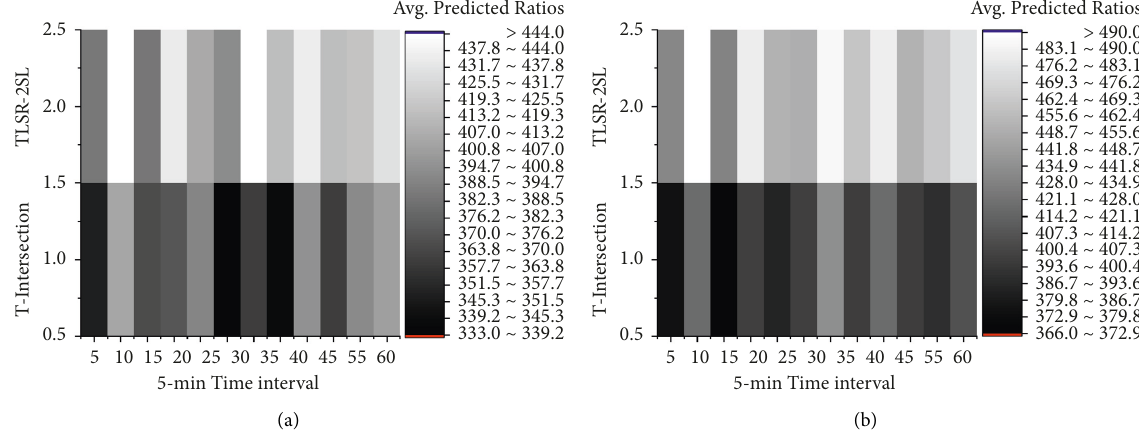
Figure 8: E-S flow comparative analysis between T-intersection and TLSR-2SL. (a) 140s signal cycle with 50m radius. (b) 140s signal cycle with 60m